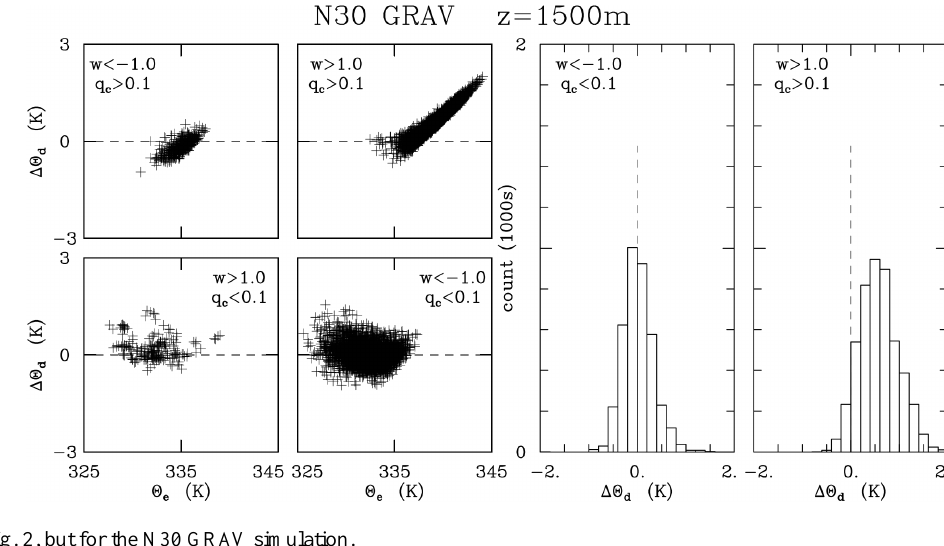
Figure 3. As Fig. 2, but for the N30 GRAV simulation.